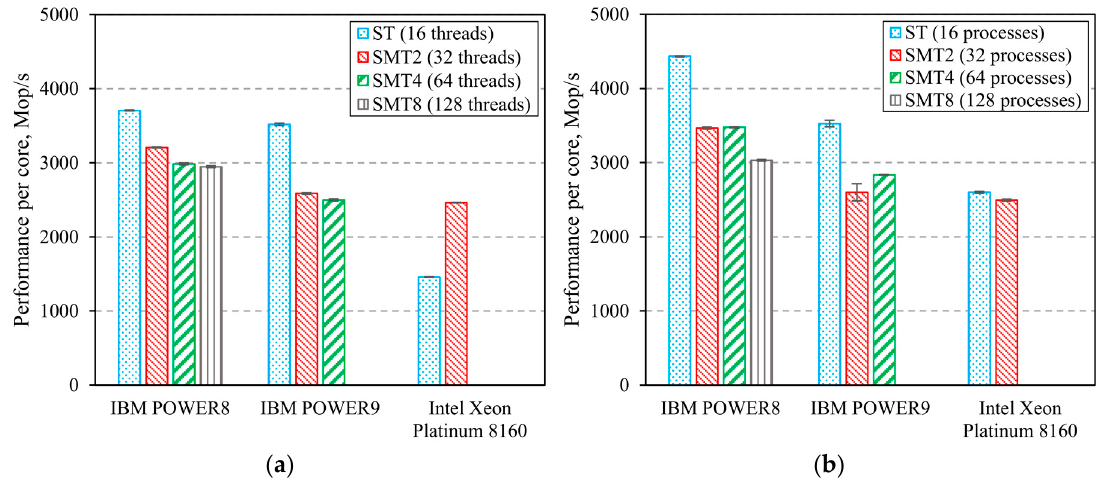
Figure 5. MG benchmark results: OpenMP version ( a ) and MPI version ( b ).